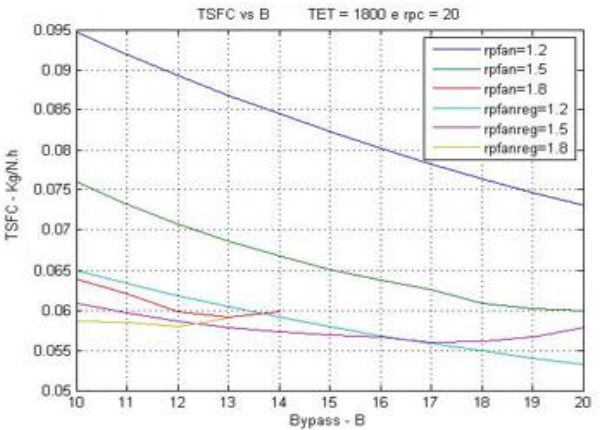
Figure 11: TSFC vs BPR with and without regeneration (TET 1800 K and rpc